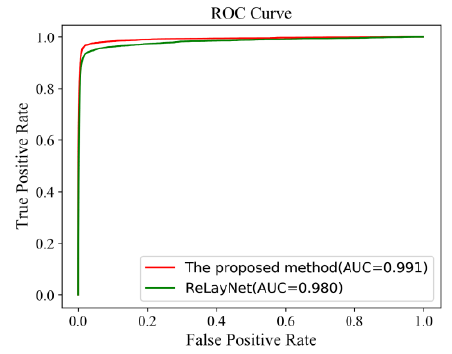
Table 7. Quantitative comparison of segmentation results around fovea edema regions for the expert 2 annotations as the ground truth.